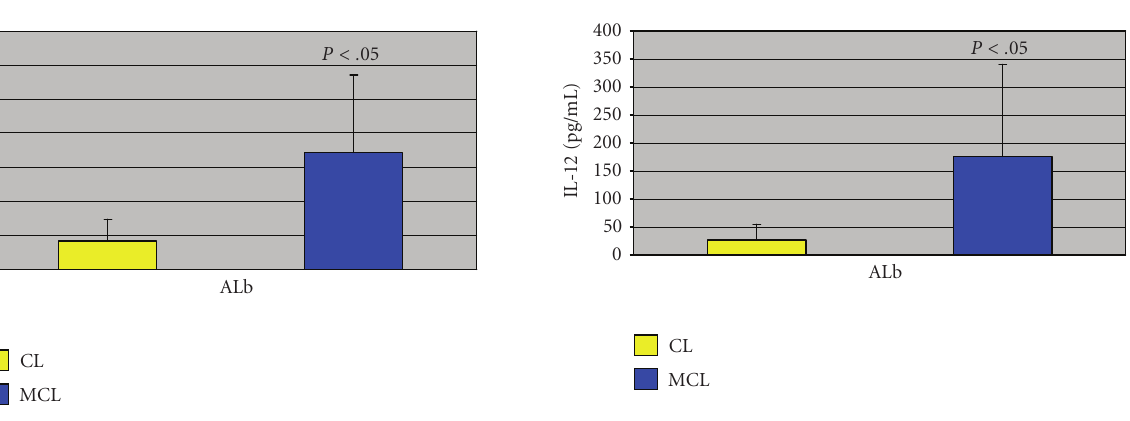
whether this mechanism of action is in fact operating in MCL treatment remains to be confirmed.